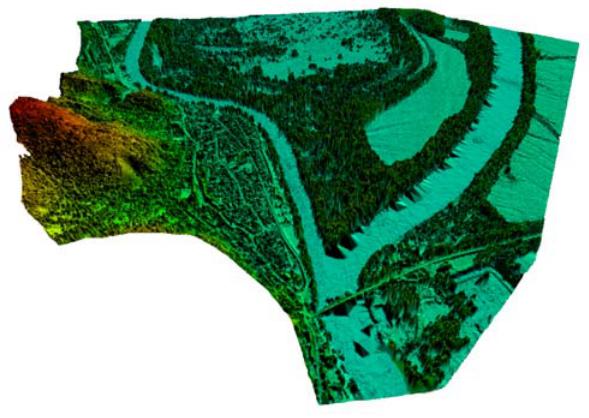
Figure 6. Digital Terrain Model for the conjunction of River Tisza and Bodrog at the city of Tokaj 2.2.4 Landsat 8 Data